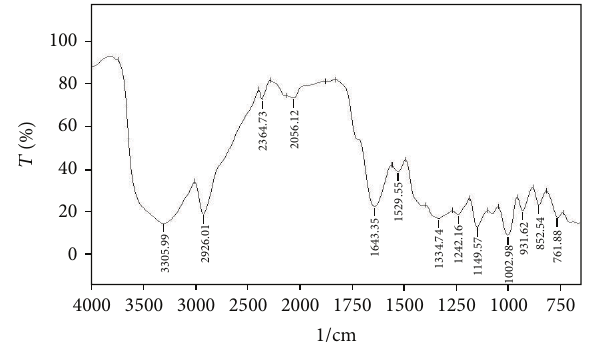
Figure 8: FT-IR spectrum of untreated PP after adsorption of BG.